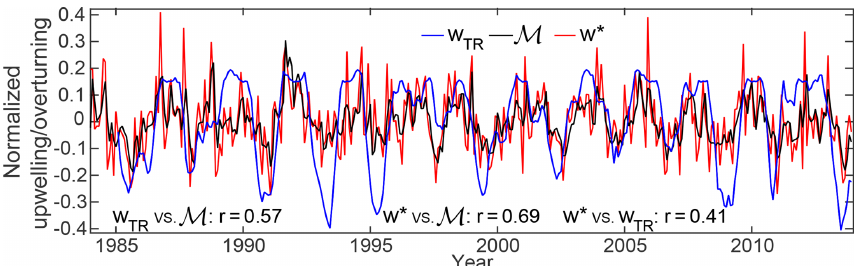
Figure 7. Time series of calculated water vapor tape recorder (blue), the global diabatic circulation (black) on 500K, and ¯ w ∗ averaged between 30 ◦ S and 30 ◦ N (red) from the WACCM model. All three time series have been deseasonalized and scaled by their standard deviations. Correlation coefficients between each pair of time series are reported at the